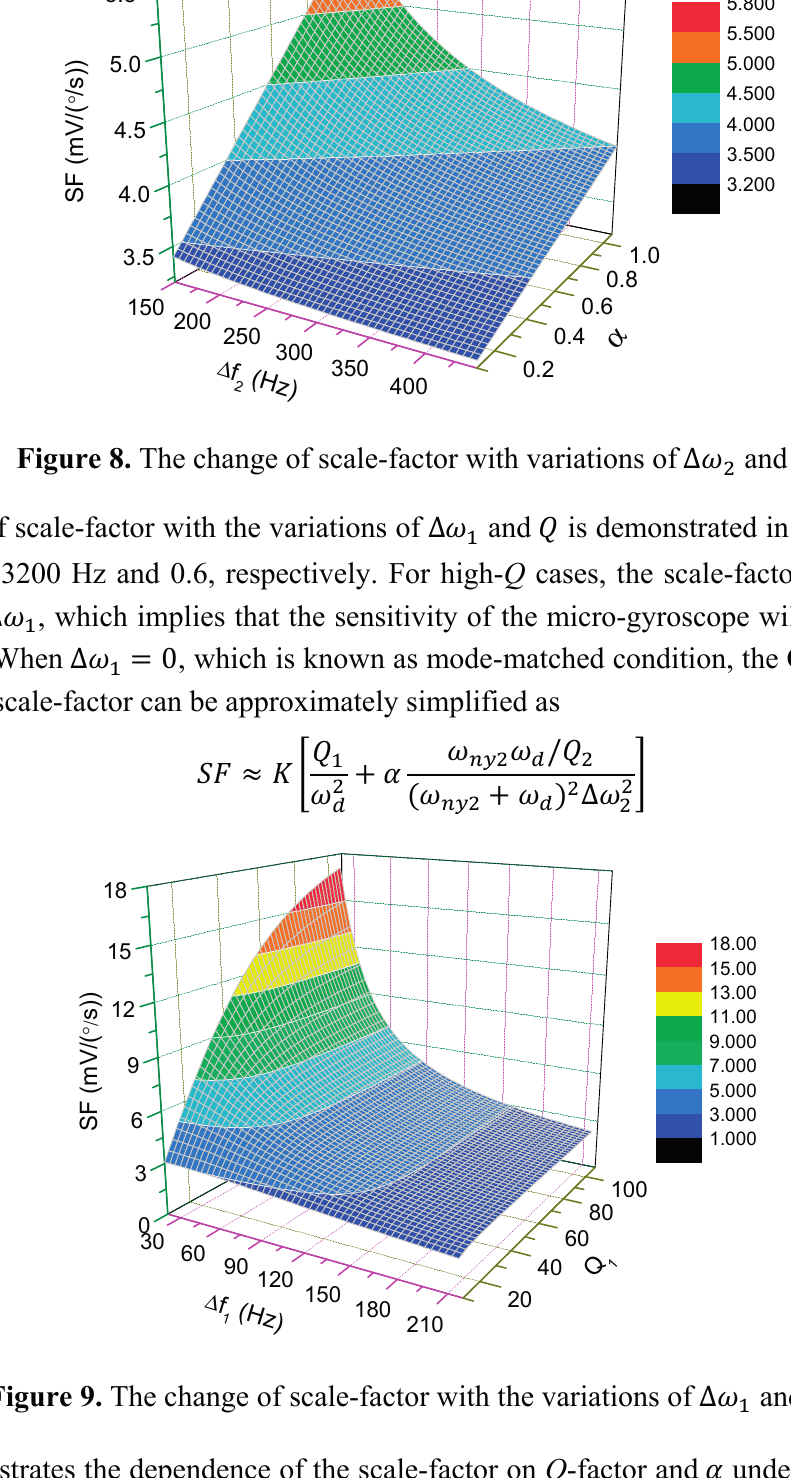
Figure 9. The change of scale-factor with the variations of ∆(cid:2033)